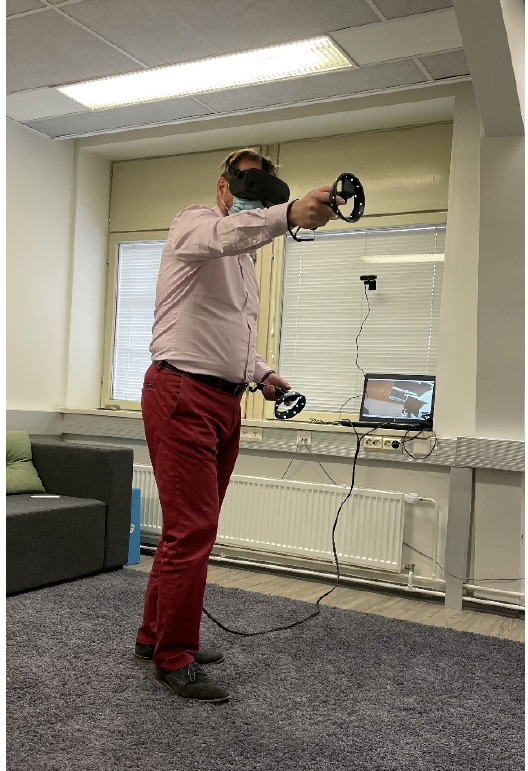
Figure 5. User tests in progress. Laptop streaming the participant’s VR view can be observed in the background. An USB camera is connected to the laptop in the background, streaming the physical space of the room to Teams.